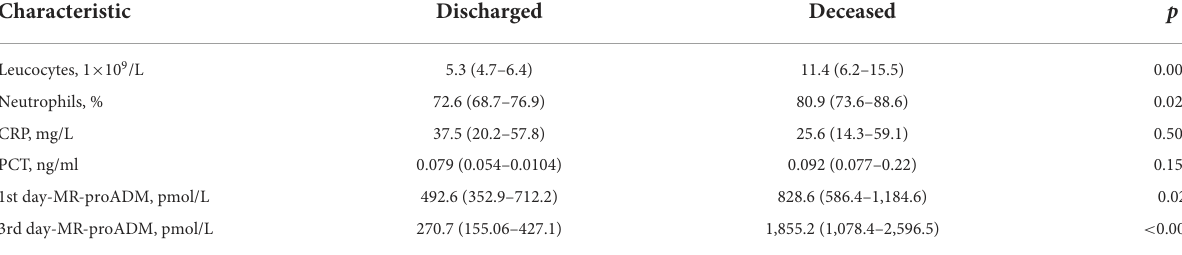
TABLE 2 Inflammatory markers.